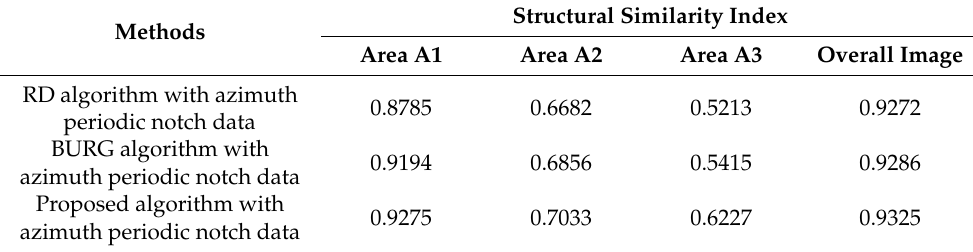
Table 4. Comparison of structural similarity